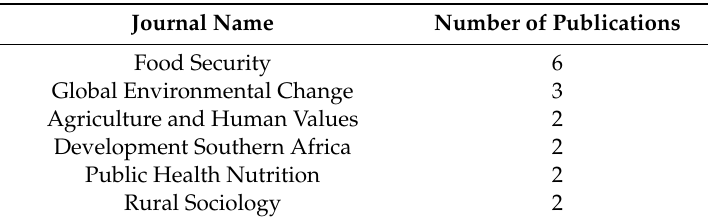
Table 2. Journals with the largest number of documents.